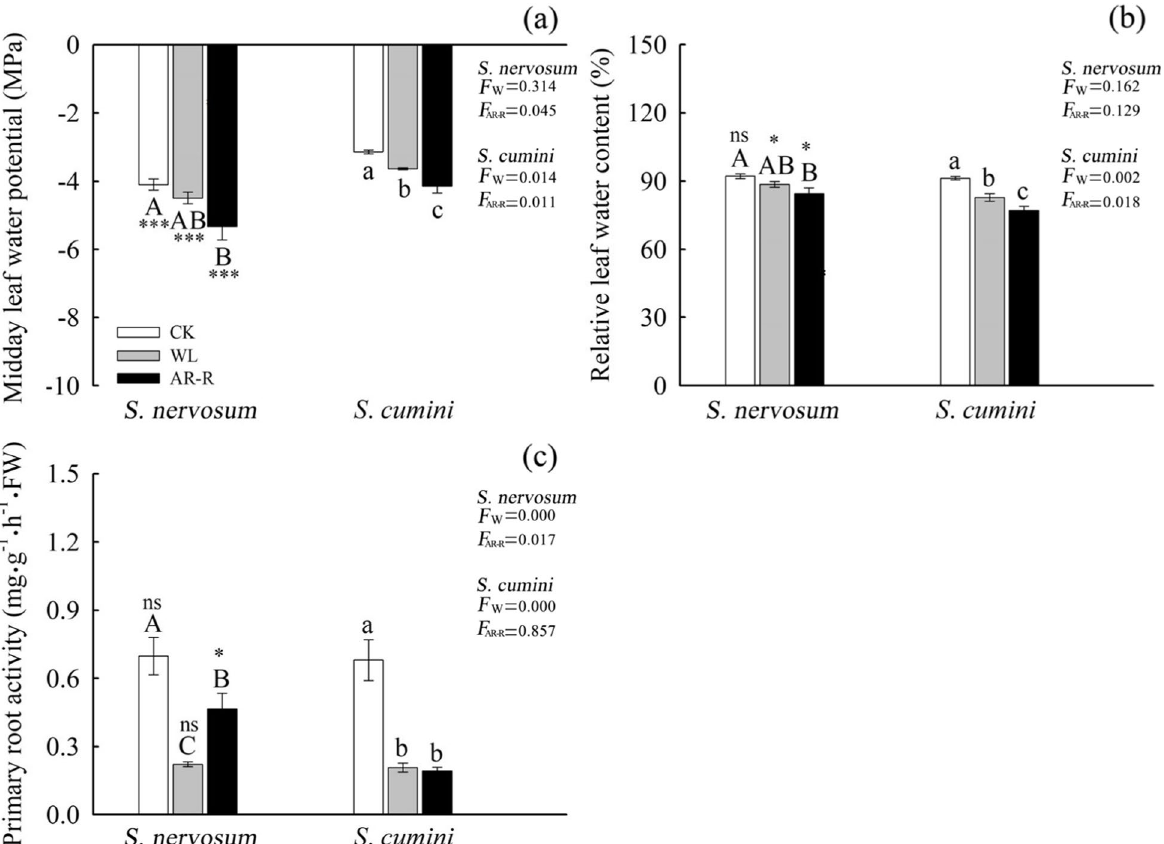
Fig. 4 Midday leaf water potential ( a ), relative leaf water content ( b ), and primary root activity ( d ) in S . nervosum and S . cumini saplings, as affected by waterlogging with or without adventitious root removal. The abbreviations, explanation of treatments, and data description and statistics are the same as shown in